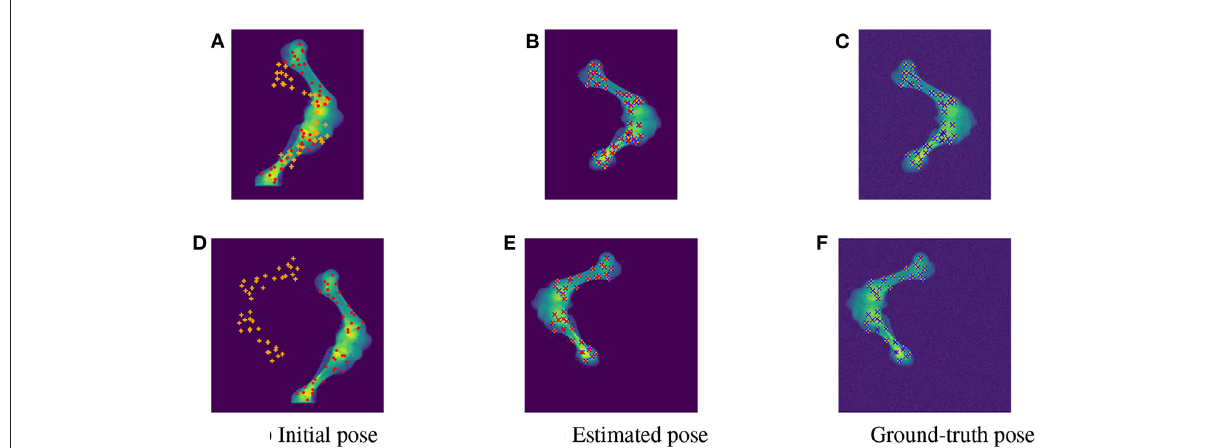
FIGURE13 Visualization of the 2D views for the initial (A,D) , estimated (B,E) , and ground-truth (C,F) poses of the two test samples with predicted (orange), ground-truth (blue), and reconstructed (red) landmarks. The 2D detected landmarks (orange) are not aligned with the computed landmarks (red) in the initial poses (A,D) . After registration, the estimated and detected landmarks align with the bones, however, the reconstructed landmarks (red) of the high error sample do not always overlap the detected landmarks (orange) (B) . This is not the case with the accurate registered sample as the ground-truth (blue), detected (orange), and registered (red) landmarks are aligned correctly (E) .